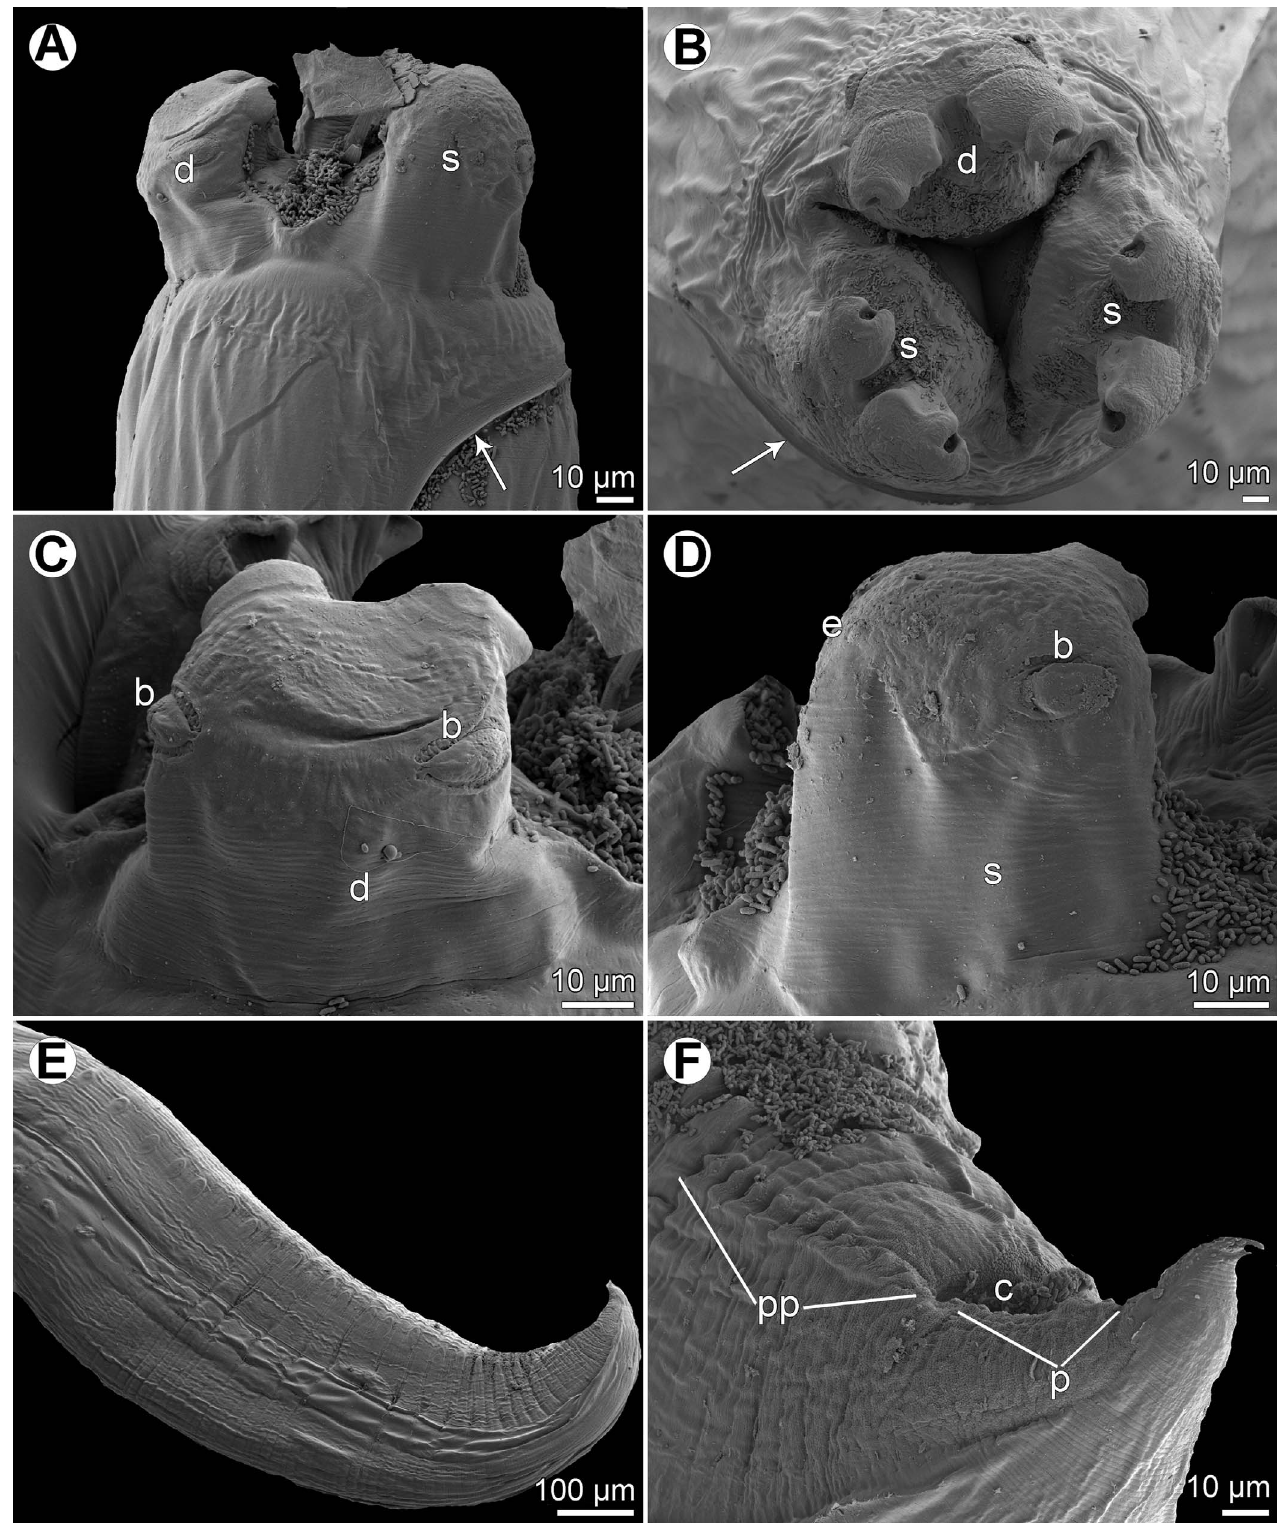
Figure 13. Raphidascaris (Ichthyascaris) elopsis n. sp., scanning electron micrographs of male. (A and B) Cephalic end, lateral and apical views, respectively (arrow indicates cuticular ala); (C) dorsal lip; (D) subventral lip; (E) posterior end of body, lateral view; (F) region of cloaca and tail, ventrolateral view. (b) Labial double papilla; (c) cloacal aperture; (d) dorsal lip; (e) amphid; (p) postanal papillae; (pp) posteriormost preanal papillae; (s) subventral